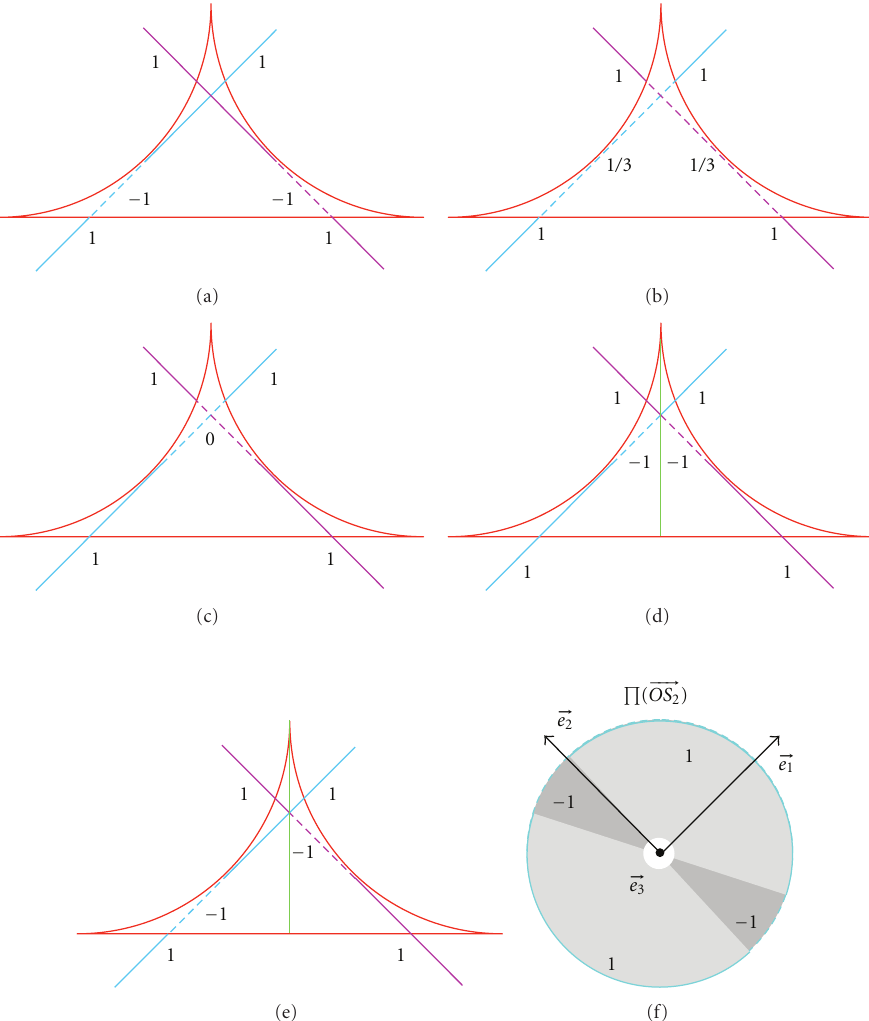
Figure 8: Examples of possible weight factors. (a) 1 − 1 + 1, (b) 1/3+1/3+1/3, (c) 0+1+0, and (d) − 1 + 1 + 1 for the left half, 1 + 1 − 1 for the right half, (e) 1 − 1 + 1 for the left half, and 1 + 1 − 1 for the right half. The straight line represents a great circle on the unit sphere. The (cid:15) −−→ weight factor in (a) for ( OS 2 ) is further illustrated in (f) as an example.